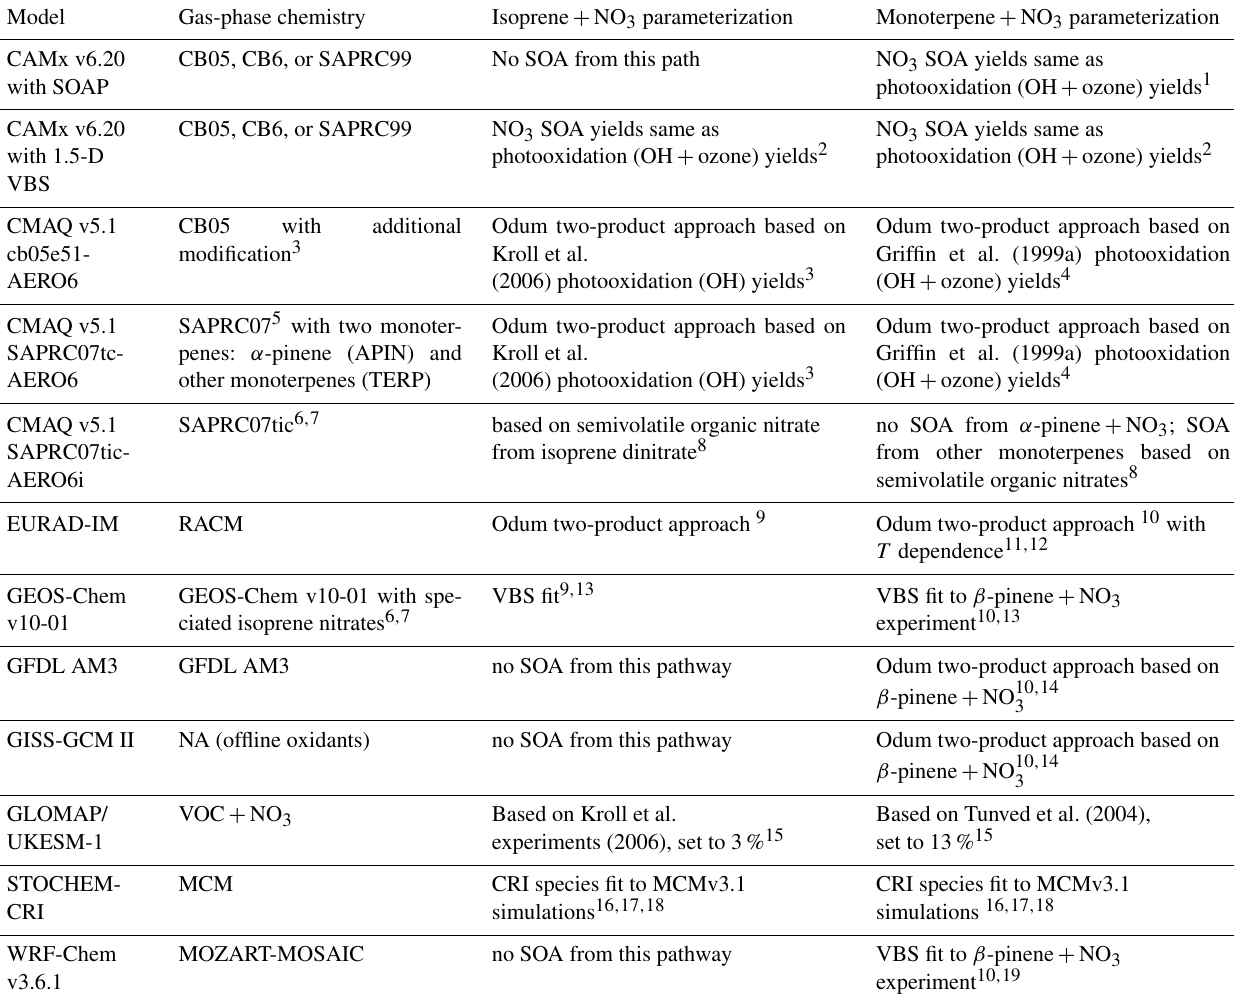
Table 5. Treatment of SOA formation from BVOC-NO 3 systems in current 3-D models.